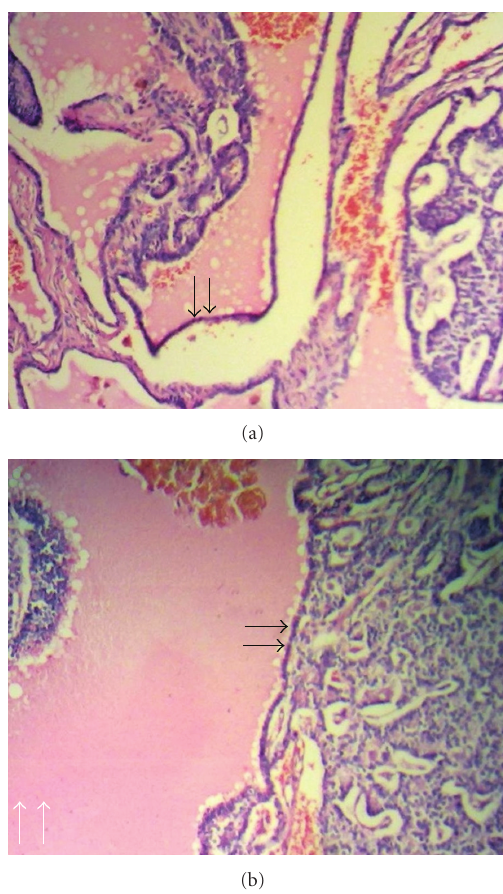
Figure 3: (a) Histopathological specimen of metastatic follicular- type carcinoma of the thyroid gland into the skin and soft tissue of amputated thumb. (b) Well-di ff erentiated epithelium is clearly distinguished (black arrows) with follicular development and colloid (white